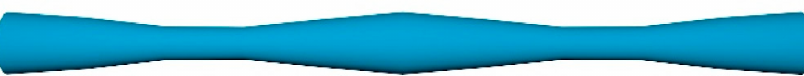
Figure 5. The schematic diagram of the double-tapered